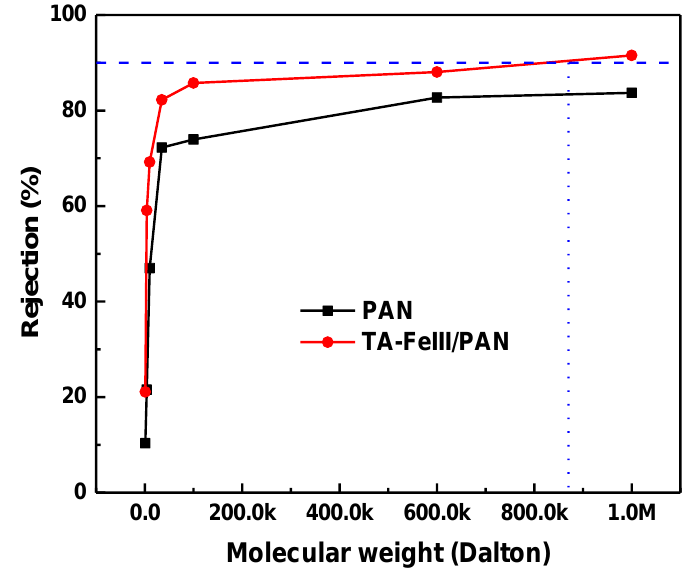
Figure 7. Molecular weight cutoff of the membranes. Table 3. Molecular weight cutoff, and pore diameter of the membranes. Geometric Mean Membrane MWCO (kDa) Pore Diameter (nm), Standard Deviation, Membrane Con- Condition PAN